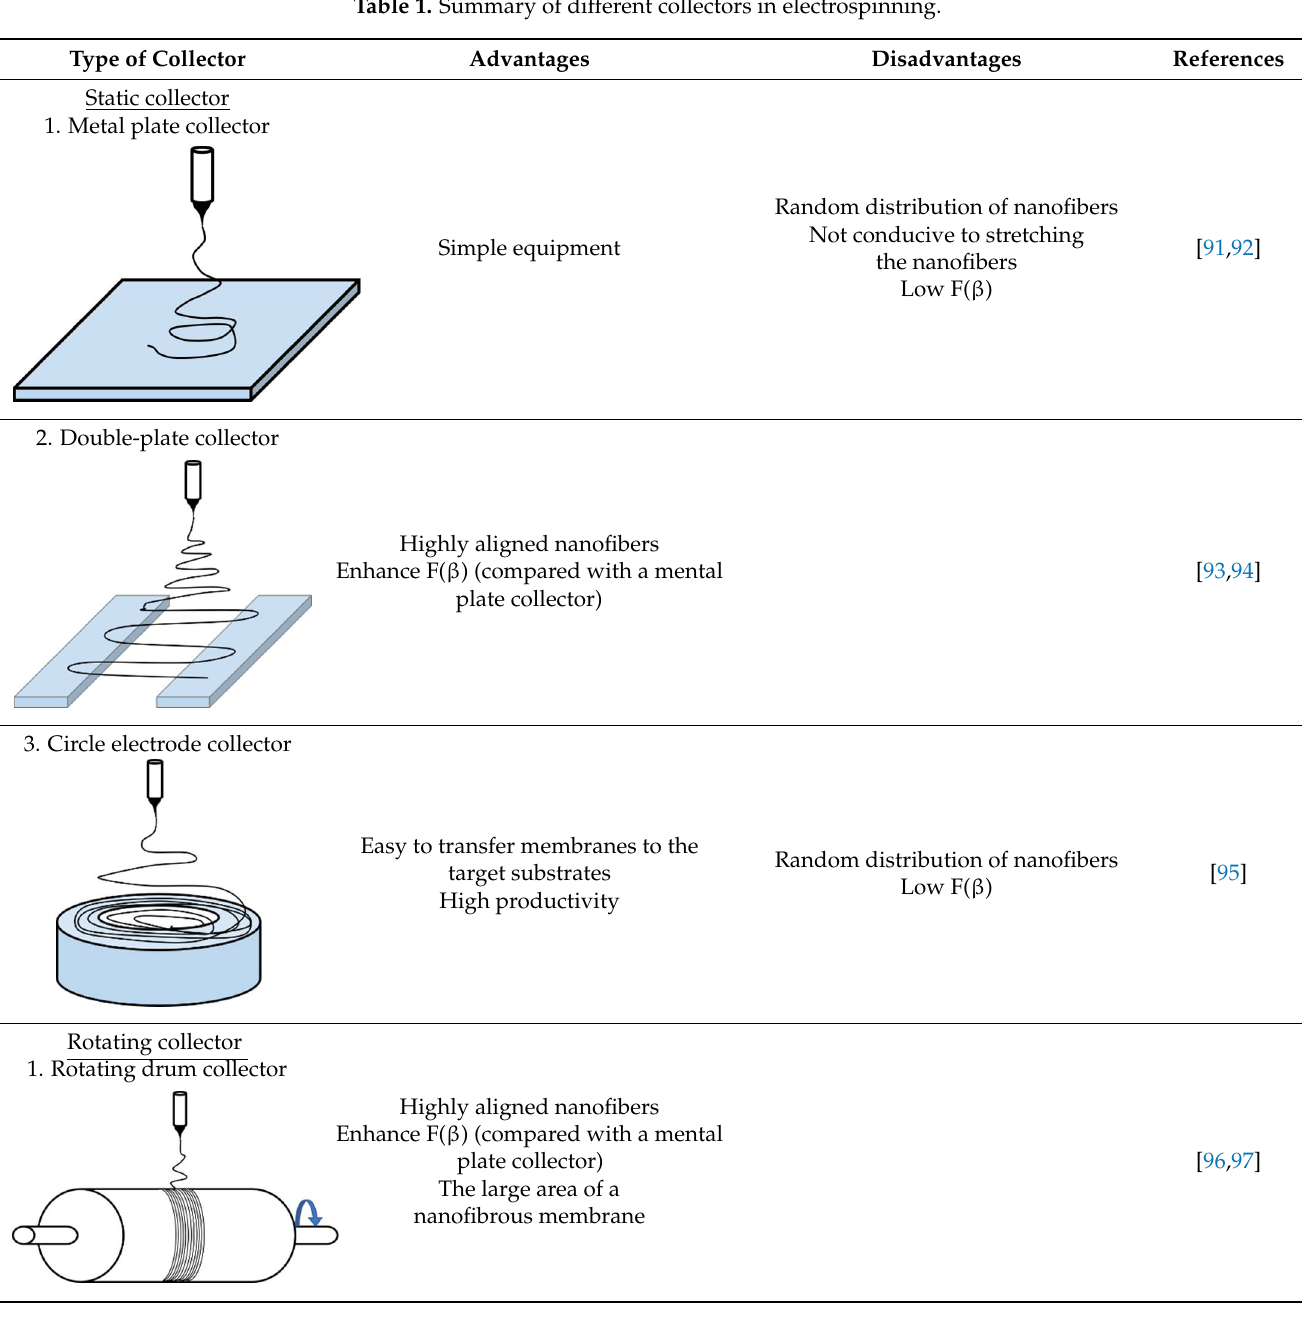
Table 1. Summary of different collectors in